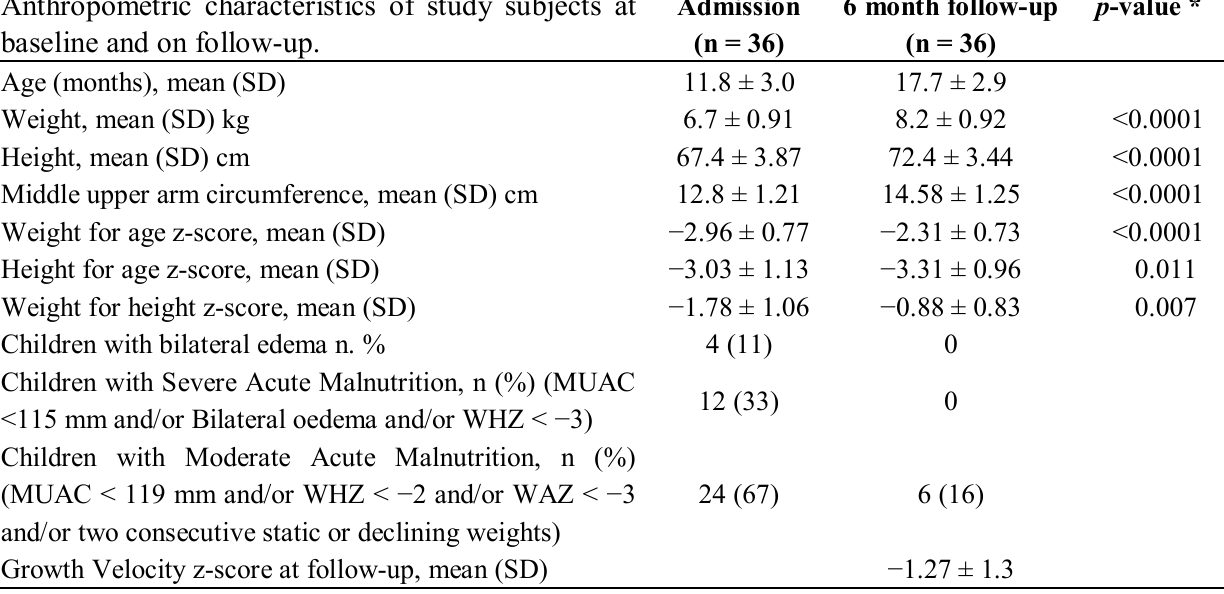
Table 2. Anthropometric characteristics of study subjects at baseline and on